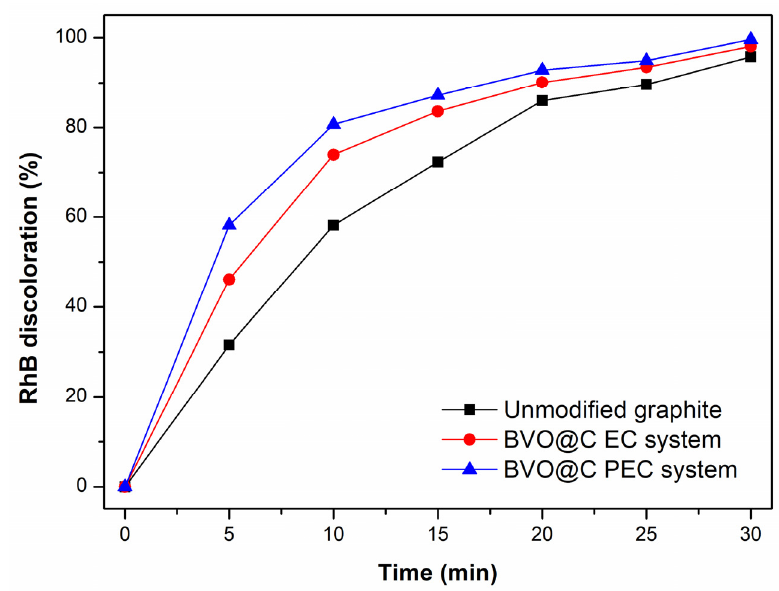
Figure 8. Electrocatalytic degradation of RhB solution (20 mg L − 1 ) in 30 min with unmodified graphite, BVO@C EC System and BVO@C PEC System, using NaCl as electrolytic support (0.05 mol L − 1 ), in pH of natural solution and at room temperature.